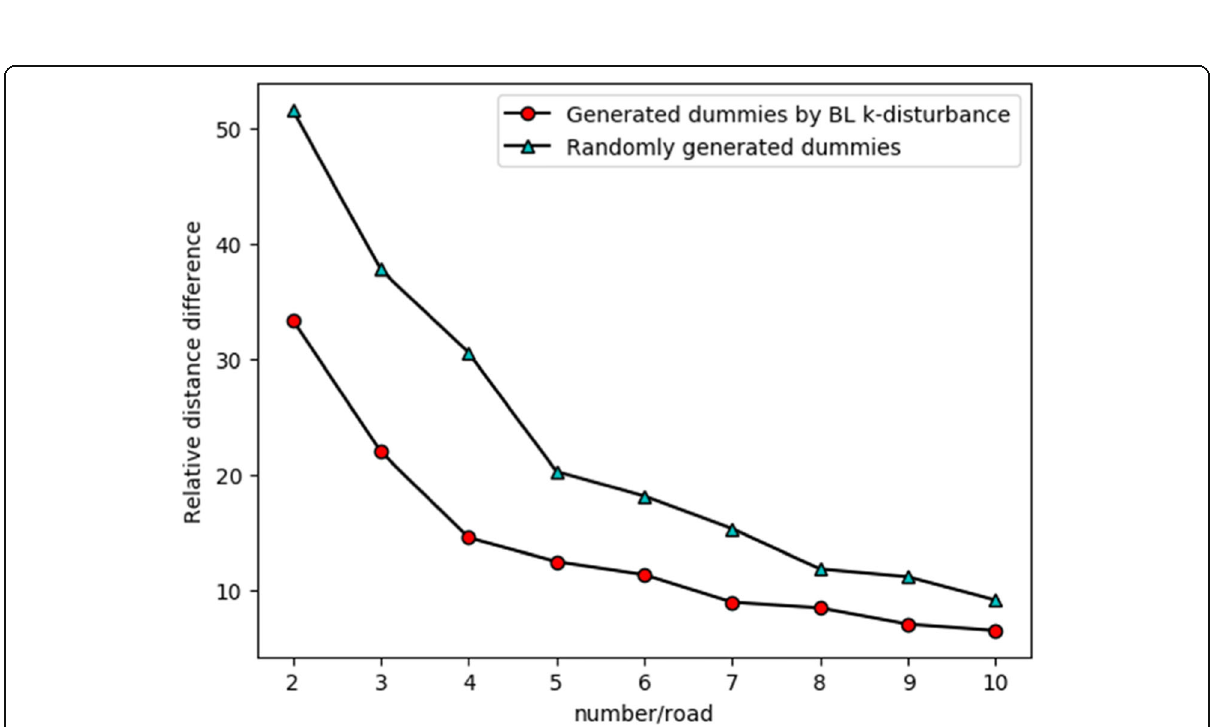
Fig. 13 The service quality of BL k- disturbance algorithm and the random false location generation algorithm. As shown in this figure, red solid circles represent generated dummies by BL k -disturbance, and blue triangle represent randomly generated dummies. The x- and y -axes represent the number of location semantic categories on each road and the relative distance difference,